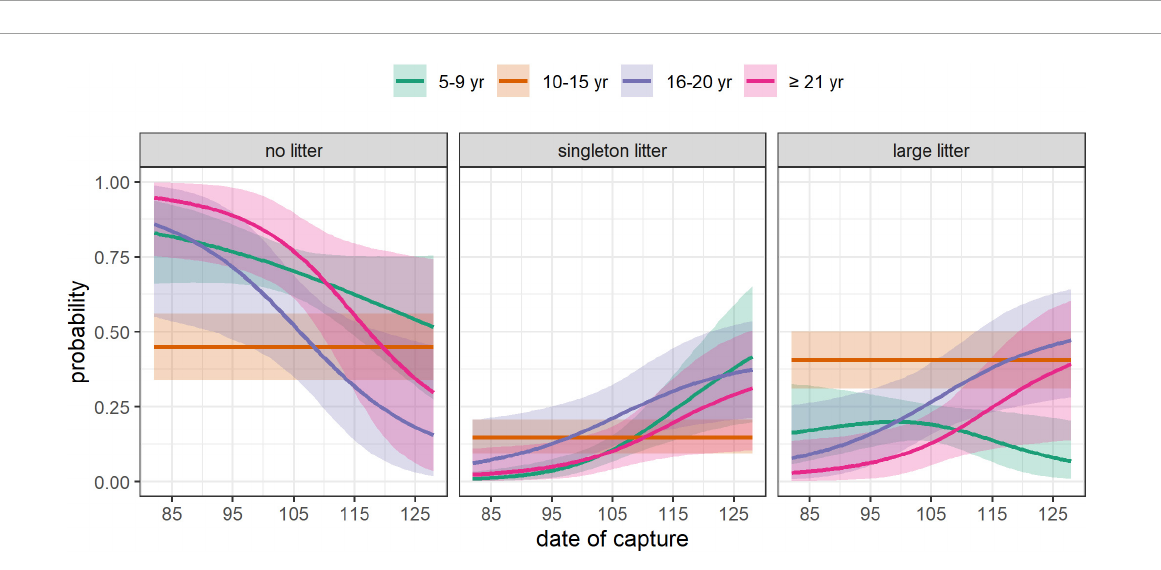
FIGURE4 Effect of date of capture on the absolute probability of having no litter, a singleton litter, or a large litter, depending on female’s age. The mean (solid line) and 95% CRI (shading) are provided. All the covariates other than DateCapture were set at their mean value ( Size = 195 cm, DateBreakUp = 174, i.e., June 23, WinterAO = –0.06, PriorWinterAO = 0.01, PriorSpringAO =